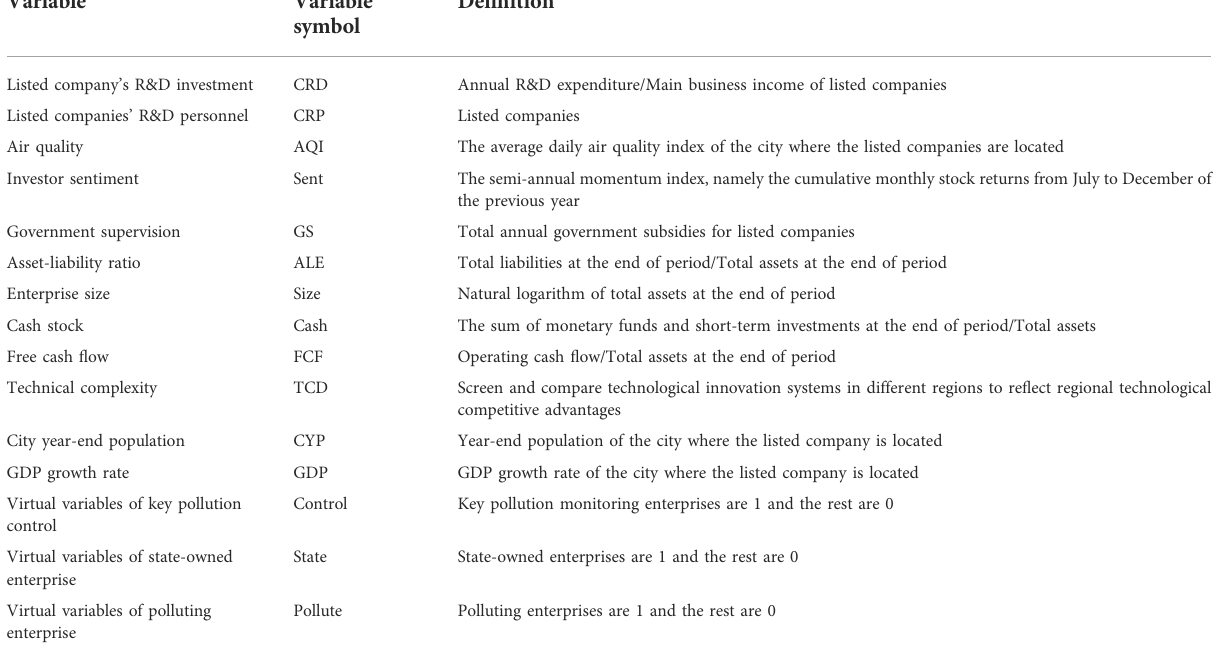
TABLE 1 Symbols and de fi nitions of